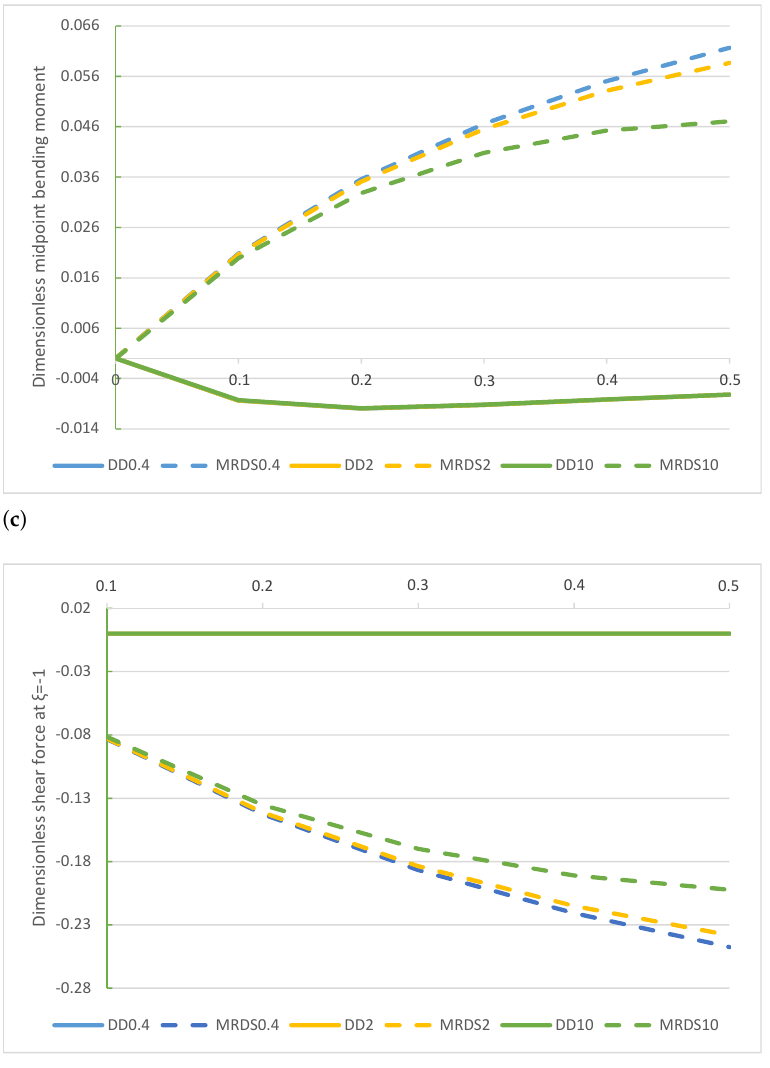
Figure 5. FF − q beam. Comparison of the DD and MRD methods for increasing values of the non-dimensional non-local parameter λ in the set